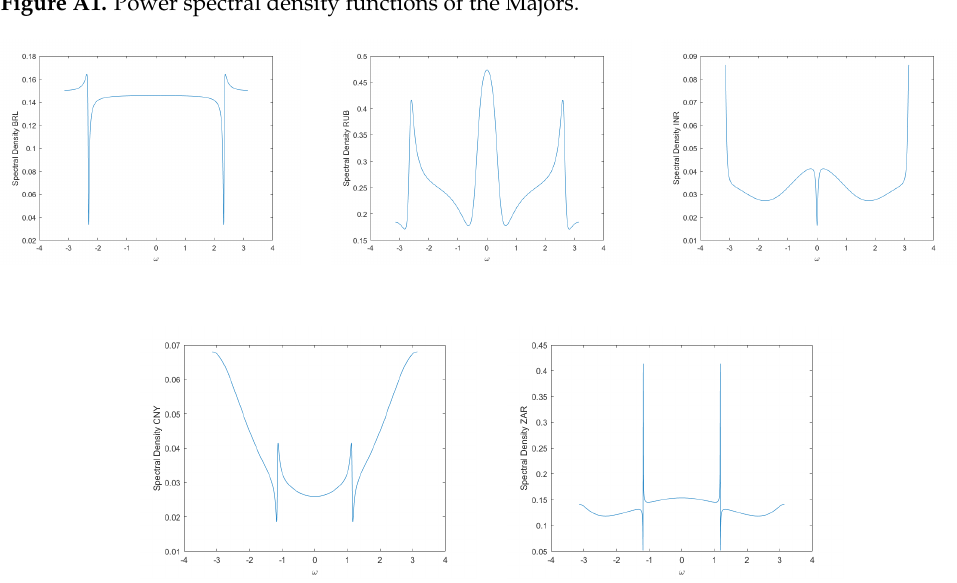
Figure A2. Power spectral density functions of the